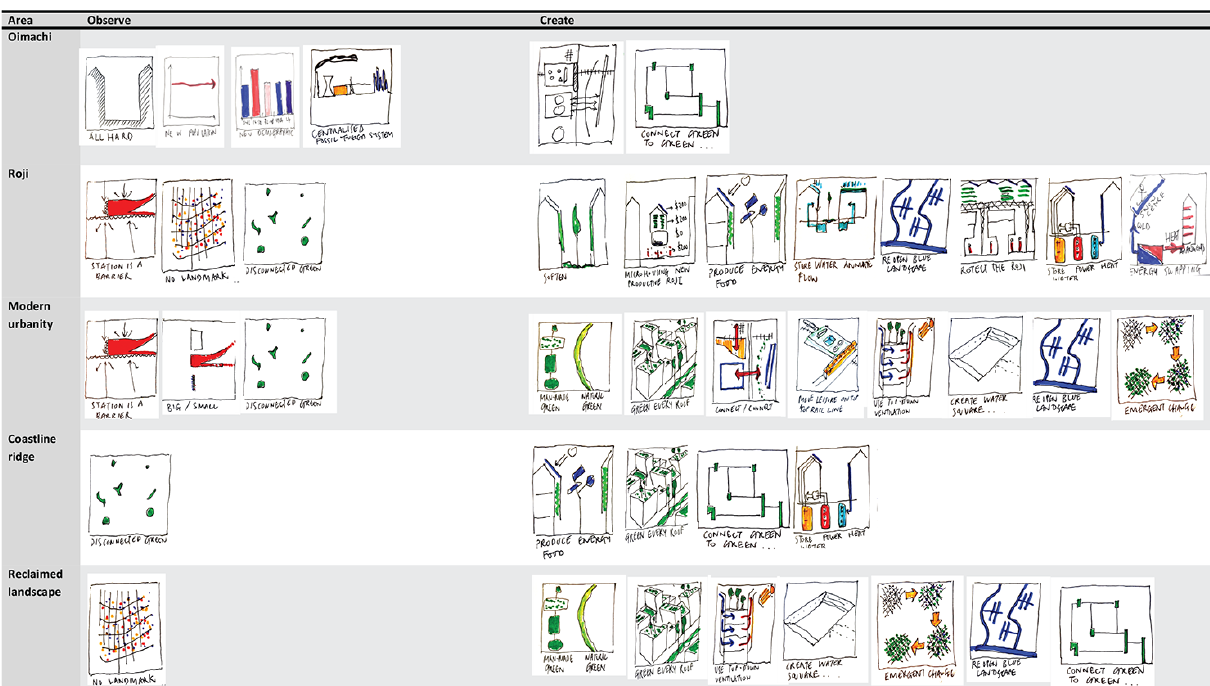
Figure 12. Allocation of deployment principles to specific urban areas. squares. At the precinct scale the main watercourses are re-established as open, publicly accessible spaces (Figure 13) with ecological added value. It allows for a greater connectedness of green spaces, urban integra- tion and an improved urban climate. These two water-